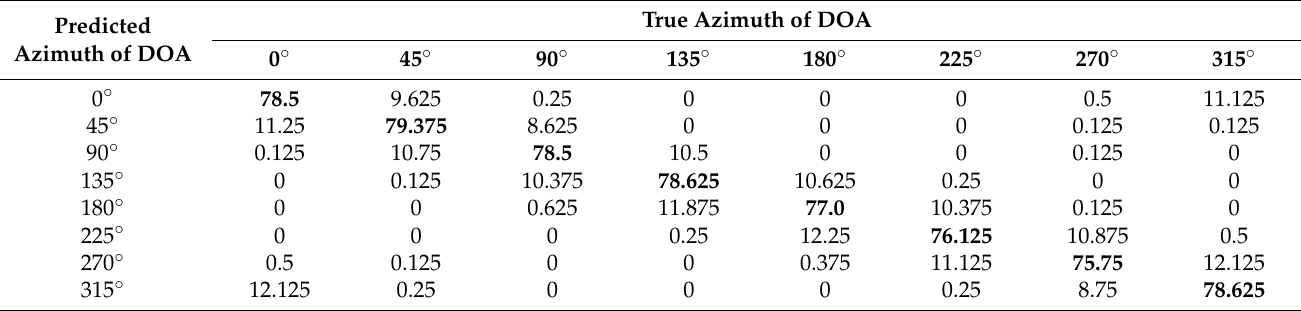
Table 1. Confusion matrix of DNNC